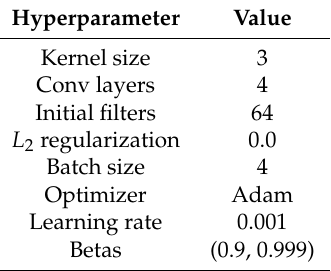
Table A5. 1D CNN implementation details. Hyperparameters for the 1D CNN yielding the highest validation set